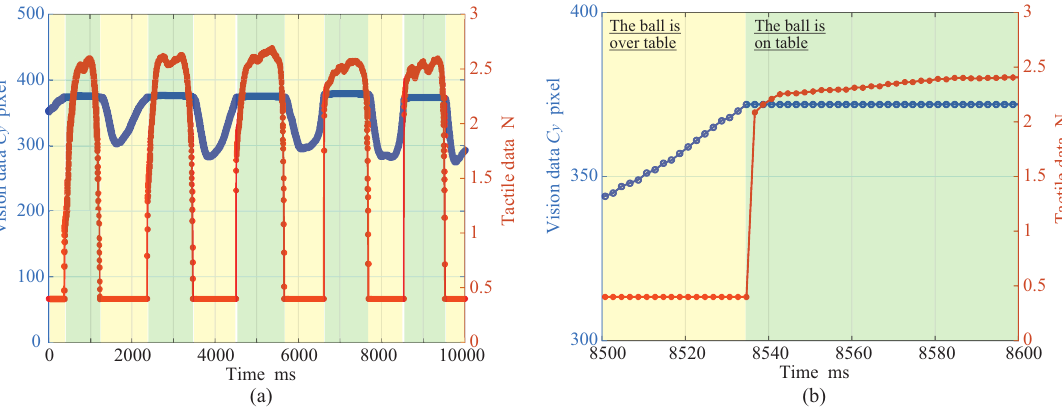
Figure 4. Result of Experiment 1: ( a ) shows tracking data and force data, and ( b ) shows enlarged result. Adapted from